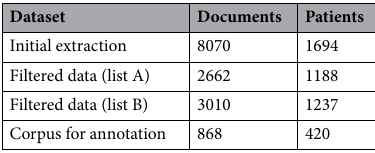
Table 4. Dataset extraction and filter steps.